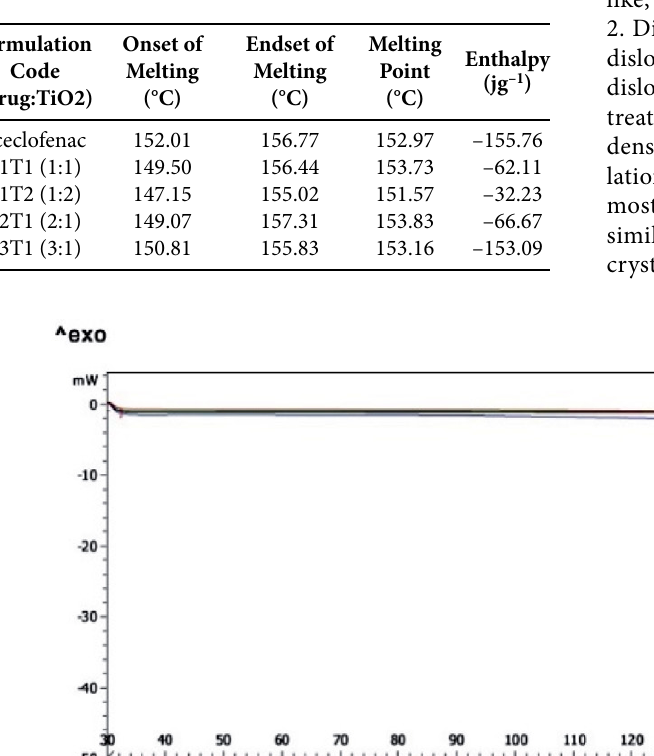
Nandi et al.: Influence of TiO 2 on Mucosal Permeation ...